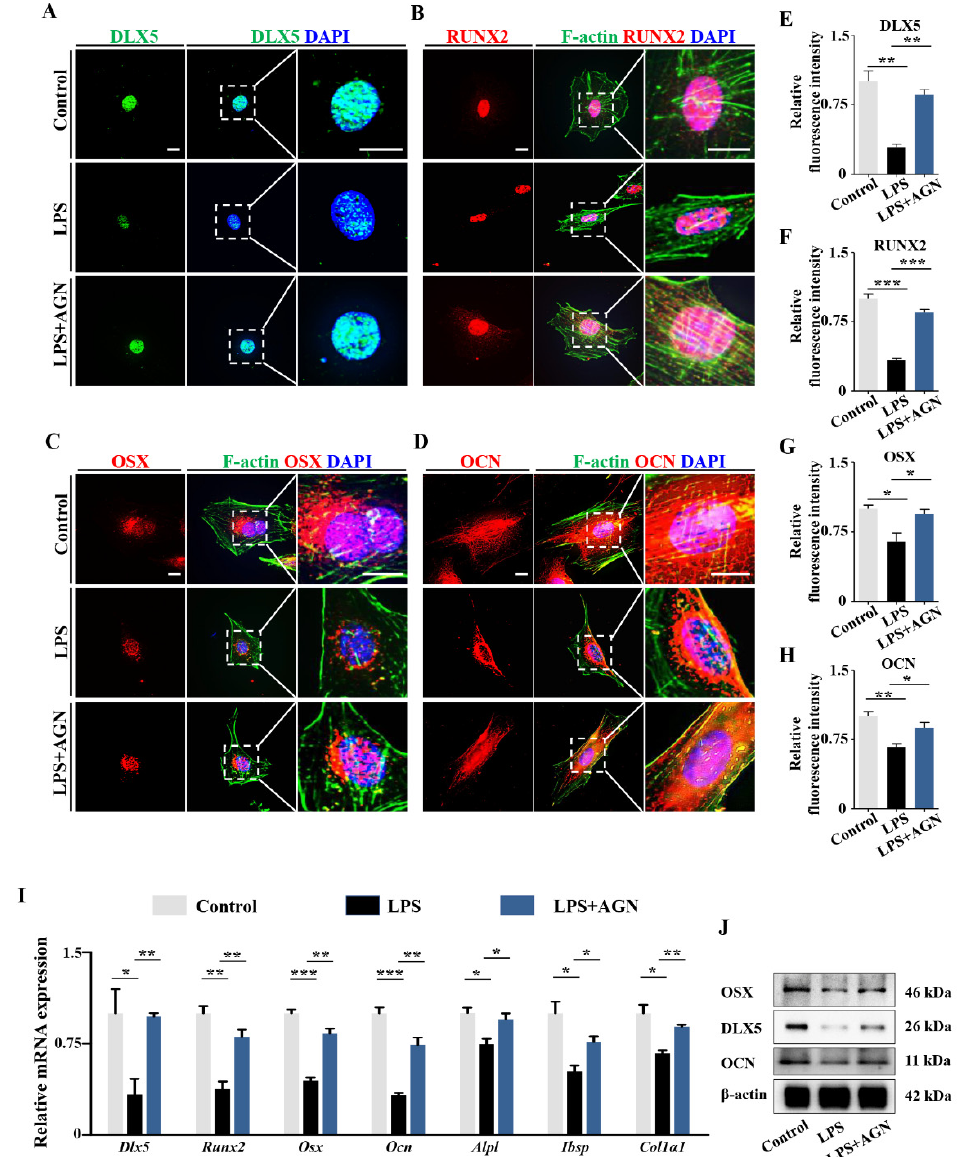
Figure 8. Determining the expression of osteogenesis-related genes following LPS treatment and blockage of RA signaling. ( A – D ) Representative images of DLX5 immunofluorescent staining on MC3T3-E1 cells, counterstained with DAPI ( A ), immunofluorescent staining of RUNX2 ( B ), Osx ( C ), and OCN ( D ), counterstained with F-actin and DAPI from control, LPS-treated, and LPS + AGN-treated groups. Negative controls were shown in Supplementary Materials (Figure S7). ( E – H ) Fluorescent staining intensities of DLX5 ( E ), RUNX2 ( F ), OSX ( G ), and OCN ( H ) from control, LPS-treated, and LPS + AGN-treated groups. ( I ) qPCR data showing the mRNA expression of Dlx5 , Osx , Runx2 , Ocn , Alpl , Ibsp , and Col1 α 1 in MC3T3-E1 cells from control, LPS-treated, and LPS + AGN-treated groups. ( J ) Western blot data showing the protein expressions of OSX, DLX5, and OCN in MC3T3-E1 cells from control, LPS-treated, and LPS + AGN-treated groups. Scale bars = 15 µ m in ( A – D ). (* p < 0.05, ** p < 0.01, *** p < 0.001)